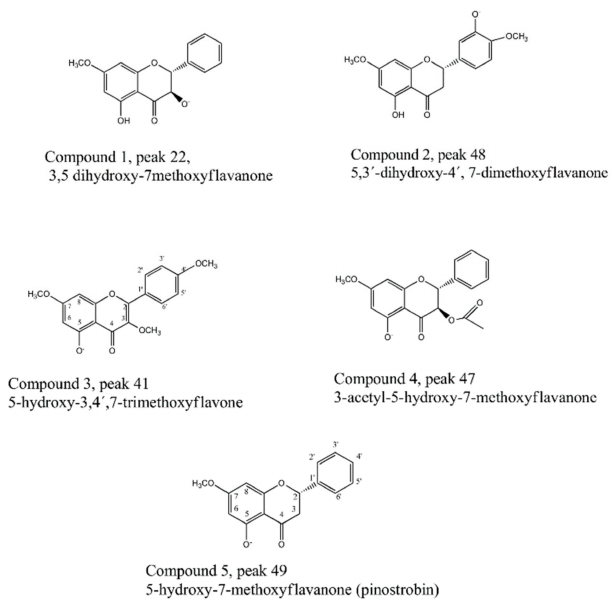
Figure 3. Structure of isolated flavonoids by high-performance counter-current chromatography